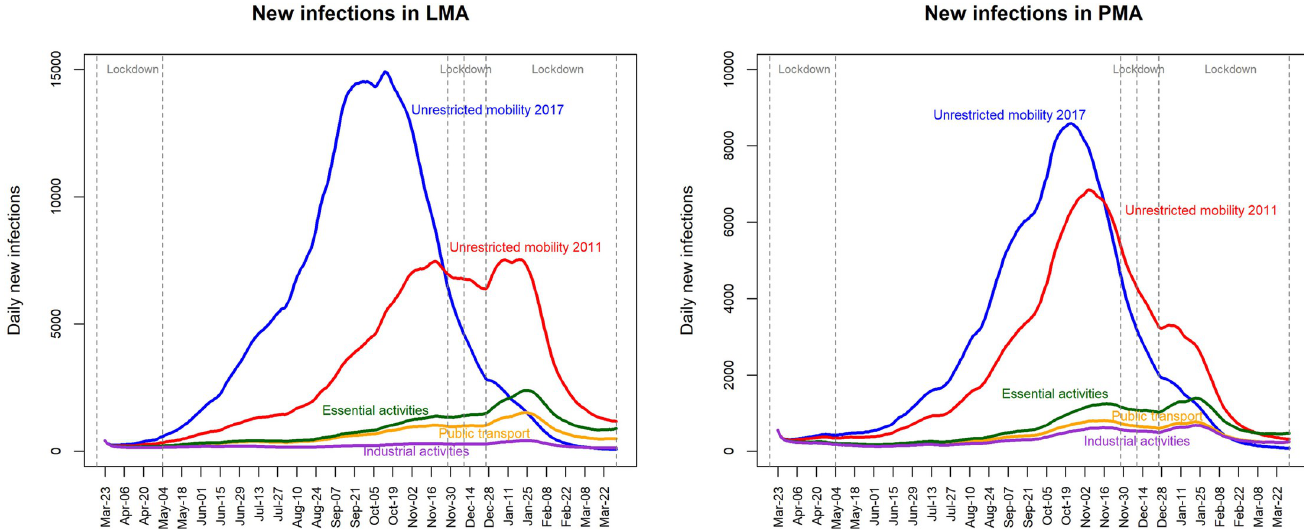
Fig 5. Simulated number of daily new infections by mobility scenario (described in Table 1), between 23 rd March 2020 and 31 st March 2021, in the metropolitan areas of Lisbon (left) and Porto (right). Stricter lockdown periods, with restrictions on intermunicipal mobility, are delimited by the vertical dashed lines and cover the periods between 23 rd March and 4 th May 2020, 28 th November to 8 th December 2020, and from 27 th December 2020 until 31 st March 2021.